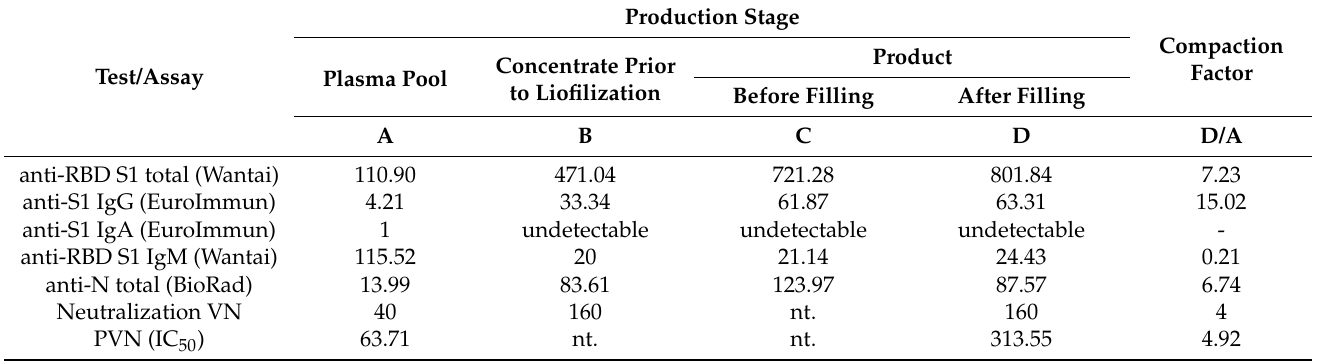
Table 1. Anti-SARS-CoV-2 antibody titer of different specificity and isotypes in the intermediates and in the FP.